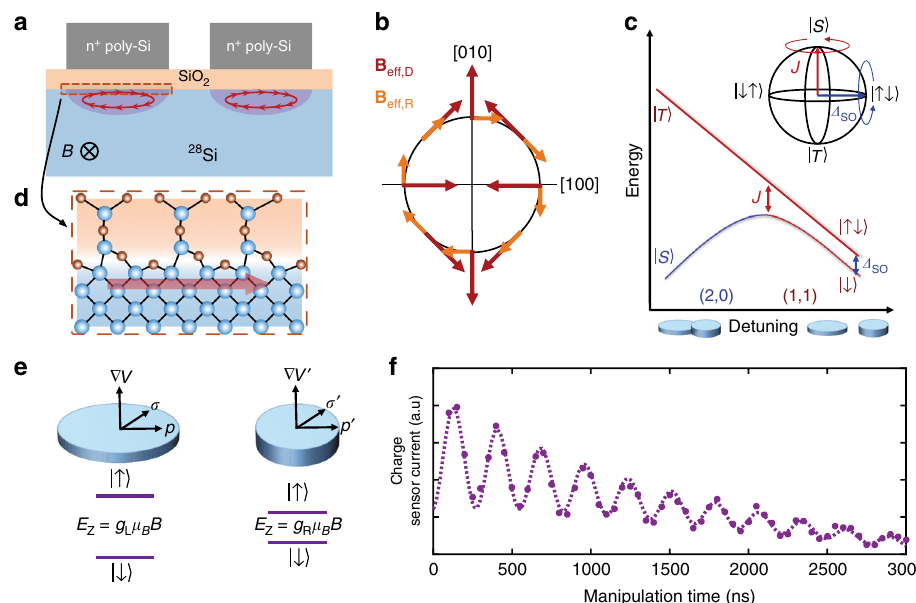
Fig. 1 MOS spin – orbit-driven singlet – triplet qubit. a Cartoon representation of the interface spin – orbit interaction. For an electron con fi ned to a QD, an in- plane magnetic fi eld will cause a fi nite momentum at the interface which, in the presence of broken inversion symmetry, leads to a spin – orbit interaction. The position of the QDs presented in this work, relative to the gates, differs from what is portrayed here (see Supplementary Fig. 2). b Schematic example of the effective spin – orbit fi eld due to the Dresselhaus (red) and Rashba (orange) interactions for in-plane electron momentum. c Schematic energy diagram of the DQD near the (2, 0) → (1, 1) charge transition, showing the energy of the singlet and triplet states as a function of QD – QD detuning, ϵ . Near the interdot transition ( ϵ = 0), the exchange energy, J , dominates the electronic interaction and drives rotations about the Z -axis (red arrow in inset). Deep into the (1, 1) charge sector ( ϵ > 0), J is small and the electronic states rotate about the X -axis due to a difference in Zeeman energy between each QD (blue arrow in inset). d Details of the interface at the inter-atomic bond level govern the spin – orbit interaction. e The local electrostatic environment of each QD leads to different momenta and electric fi elds at the interface and, thus, distinct spin – orbit interactions and Zeeman energy splitting. f Charge sensor current as a function of time spent deep in the (1, 1) charge sector, where higher current indicates a higher probability of measuring a singlet state. The oscillations indicate clear X -rotations due to a difference in spin – orbit interaction in each